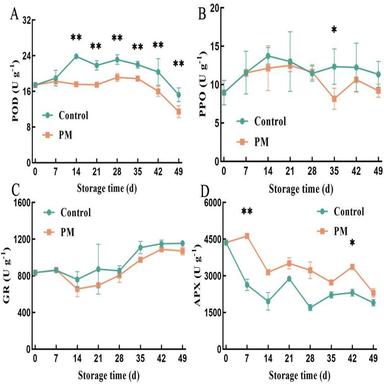
Effect of the treatment of PM on the activities of POD (A), PPO (B), GR (C), and APX (D) of sweet cherries during storage at 0±2 ◦C from 0 d to 49 d. Each value represents the mean for three replicates, and vertical bars indicates the standard deviations for each treatment (n = 3). The symbol \ represent significant statistical differences (p < 0.05).